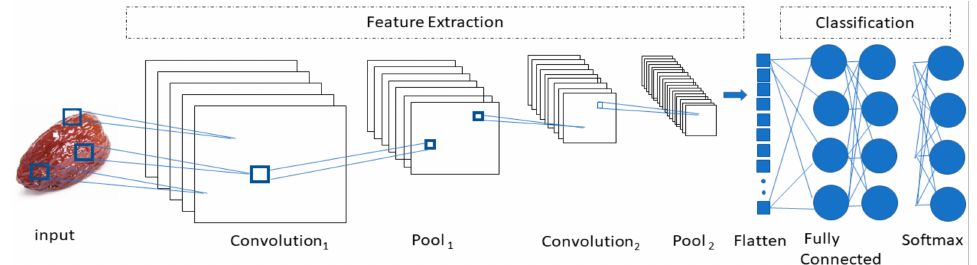
Figure 2. Representation of a basic convolutional neural network